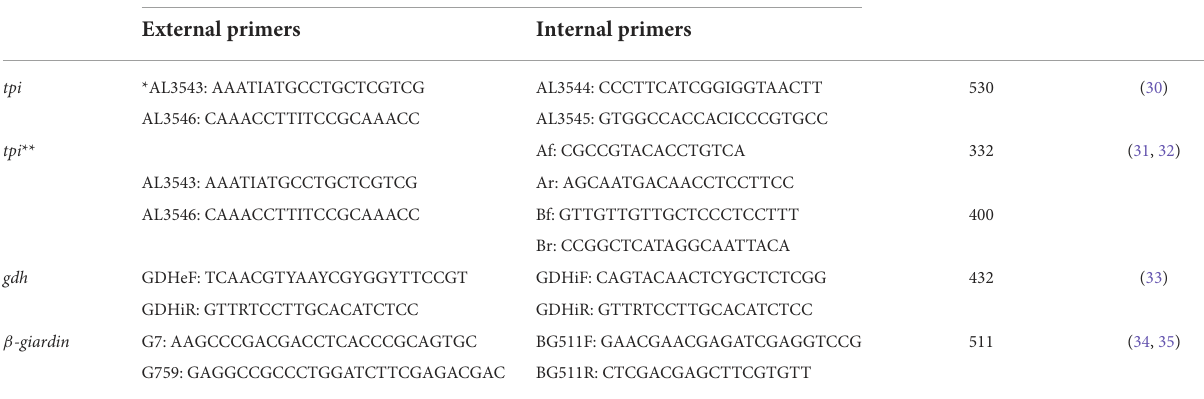
TABLE 1 Primer sequences and target genes used for molecular identification of Giardia duodenalis assemblages and multilocus sequence genotyping. Target